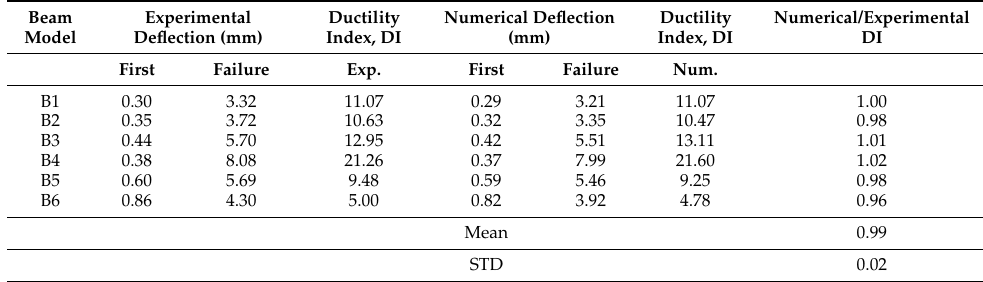
Table 5. Comparison of the experimental and numerical results of the ductility indexes at the first crack and at failure at mid-span of the beam